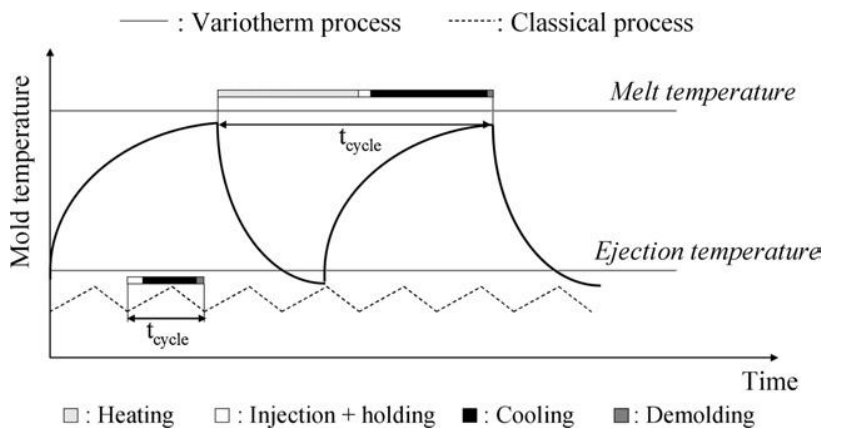
Figure 4. Comparison of mold temperature in the classical and variotherm processes. Adapted, with permission, from [54]. 2007, IOPscience.